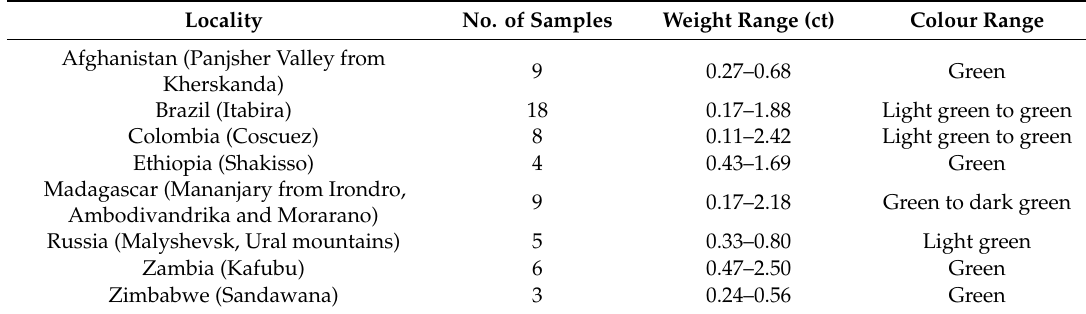
Table 1. List of studied samples, along with their weight and colour ranges. Locality No. of Samples Weight Range (ct) Colour Range Afghanistan (Panjsher Valley from